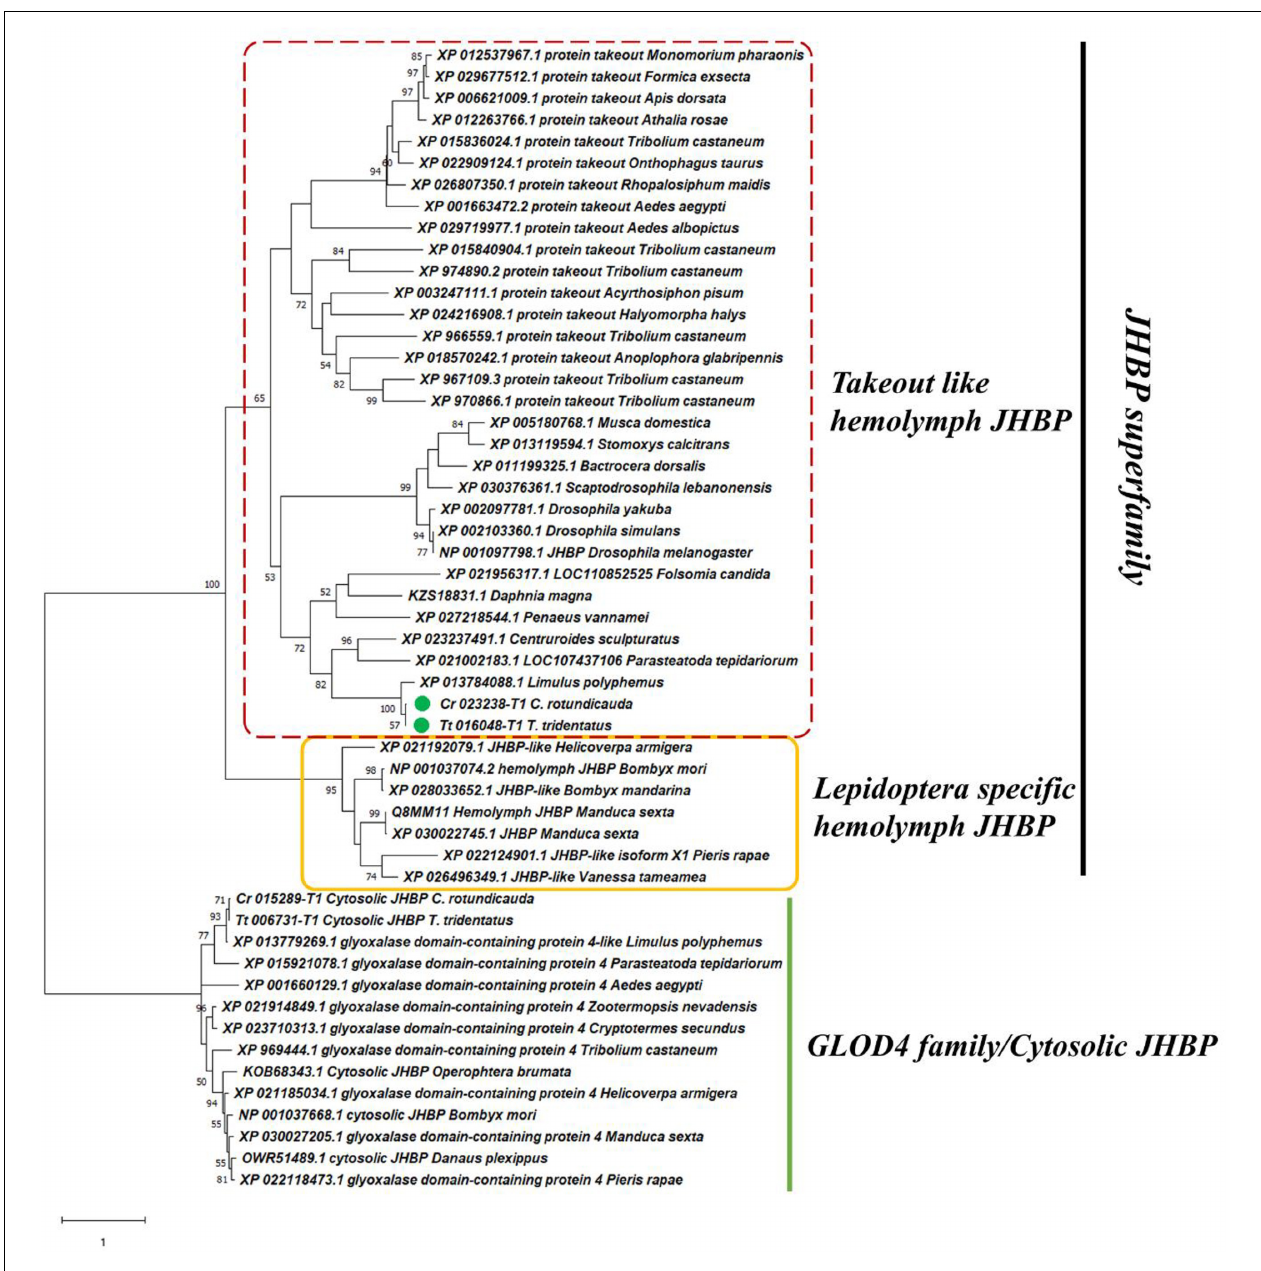
FIGURE 2 | Phylogenetic relationship of juvenile hormone binding protein (JHBP) family. Maximum-likelihood phylogenetic tree showing potential hemolymph JHBP (hJHBP) revealed in horseshoe crab hemolymph. The percentage of replicate trees in which the associated taxa clustered together in the bootstrap test (1,000 replicates) are shown next to the